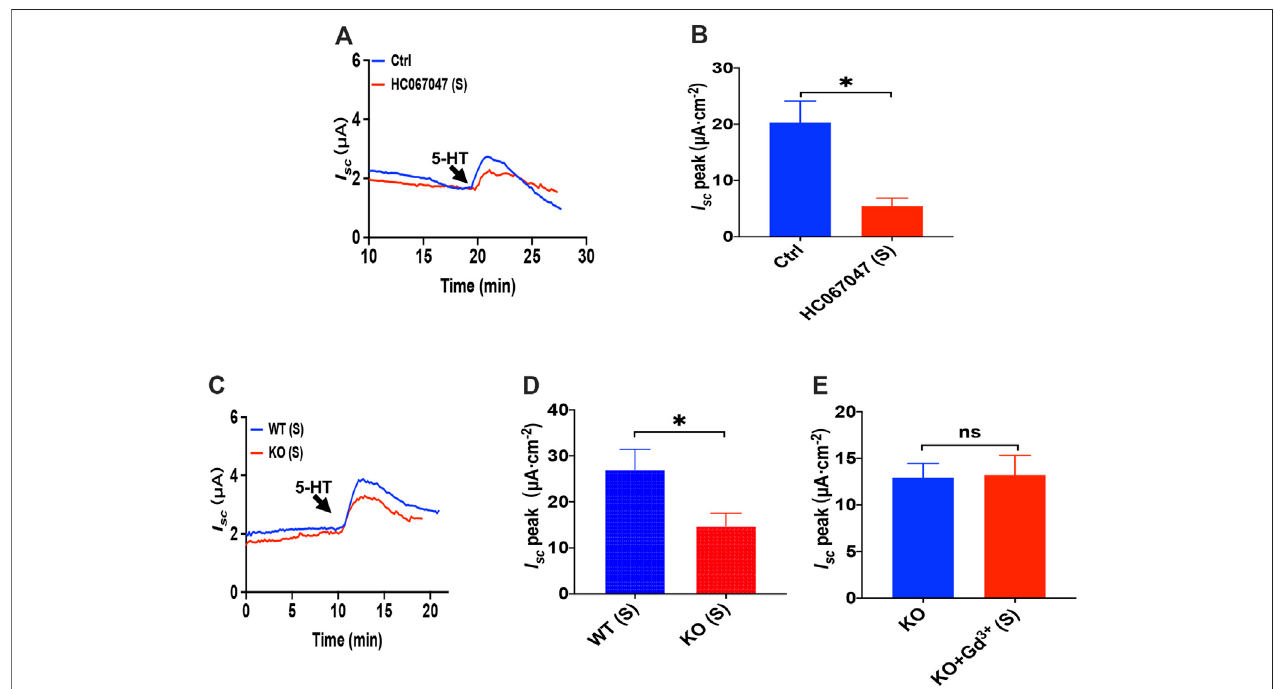
FIGURE 7 | 5-HT induced duodenal ion secretion via serosal TRPV4 channels. (A,B) 5-HT-evoked I sc after HC067047 (30 μ M, n (cid:2) 6) was added to the serosal (s) side. (C,D) 5-HT (10 μ M) -evoked I sc in wild-type (W.T.) or TRPV4 knockout (K.O.) mice ( n (cid:2) 6). (E) 5-HT-evoked I sc after GdCl (Gd 3+ , 30 μ M, n (cid:2) 6) was added to the serosal(s)sideoftheTRPV4KOmiceduodenum.Ctrlrepresentsthecontrolwithoutdrugtreatment.Resultsarepresentedasmean ± SE.NS,nosigni fi cantdifferences, * p < 0.05 vs. corresponding control by Student ’ s unpaired, two-tailed t-test.